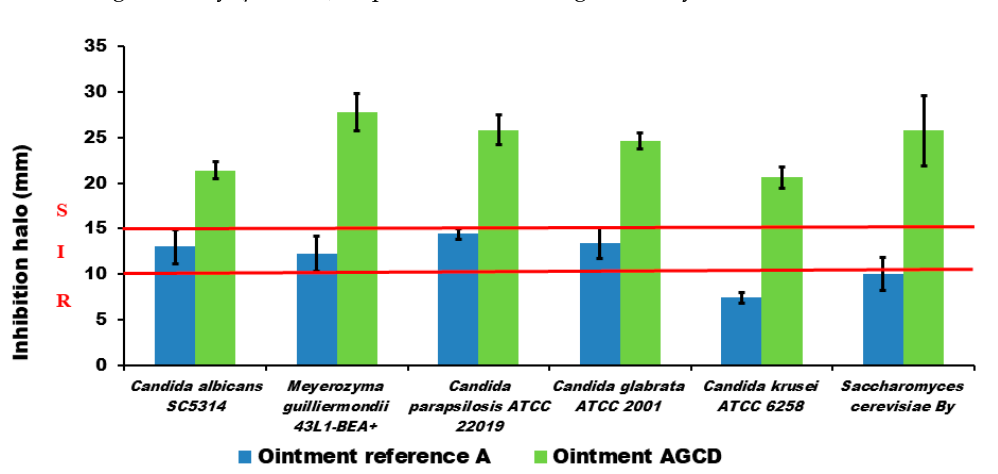
Figure 5. Antifungal in vitro activity of two semisolid AmB formulations against different species of Candida and Saccharomyces cerevisiae ( By ). One is an AmB reference ointment, and the other is an ointment with the AmB previously solubilized by cyclodextrins (Solution AGCD). The growth inhibition halo diameters were measured at points where there was a complete inhibition of yeast growth. The isolates were classified as susceptible (S) to AmB when the inhibition zone was ≥ 15 mm, resistant (R) when it was ≤ 10 mm, and intermediate (I) or susceptible-dose dependent when the inhibition zone was between 10–14 mm [19]. Growth inhibition halo diameters are expressed as mean ± SD and are in mm. Each experiment was performed in triplicate. No antifungal activity measured as halo inhibition (<1 mm) was observed with Orabase ® , DMSO, and γ -cyclodextrins